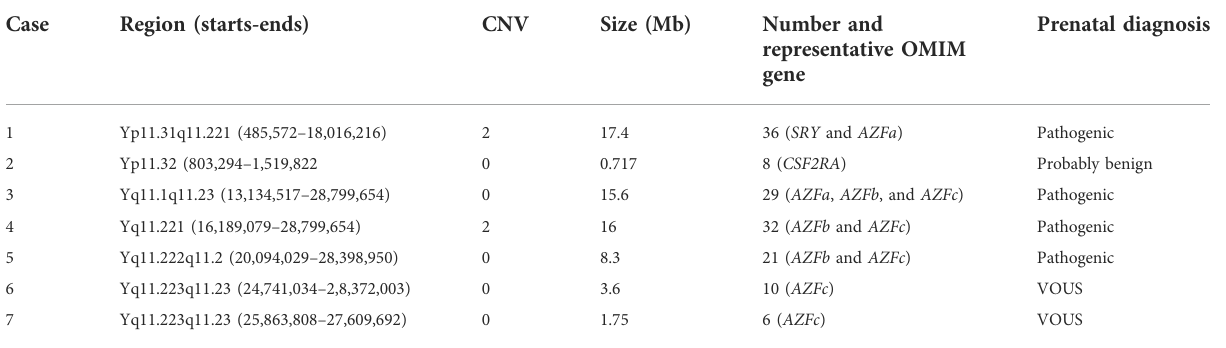
TABLE 5 Y chromosomal deletions/duplications in male